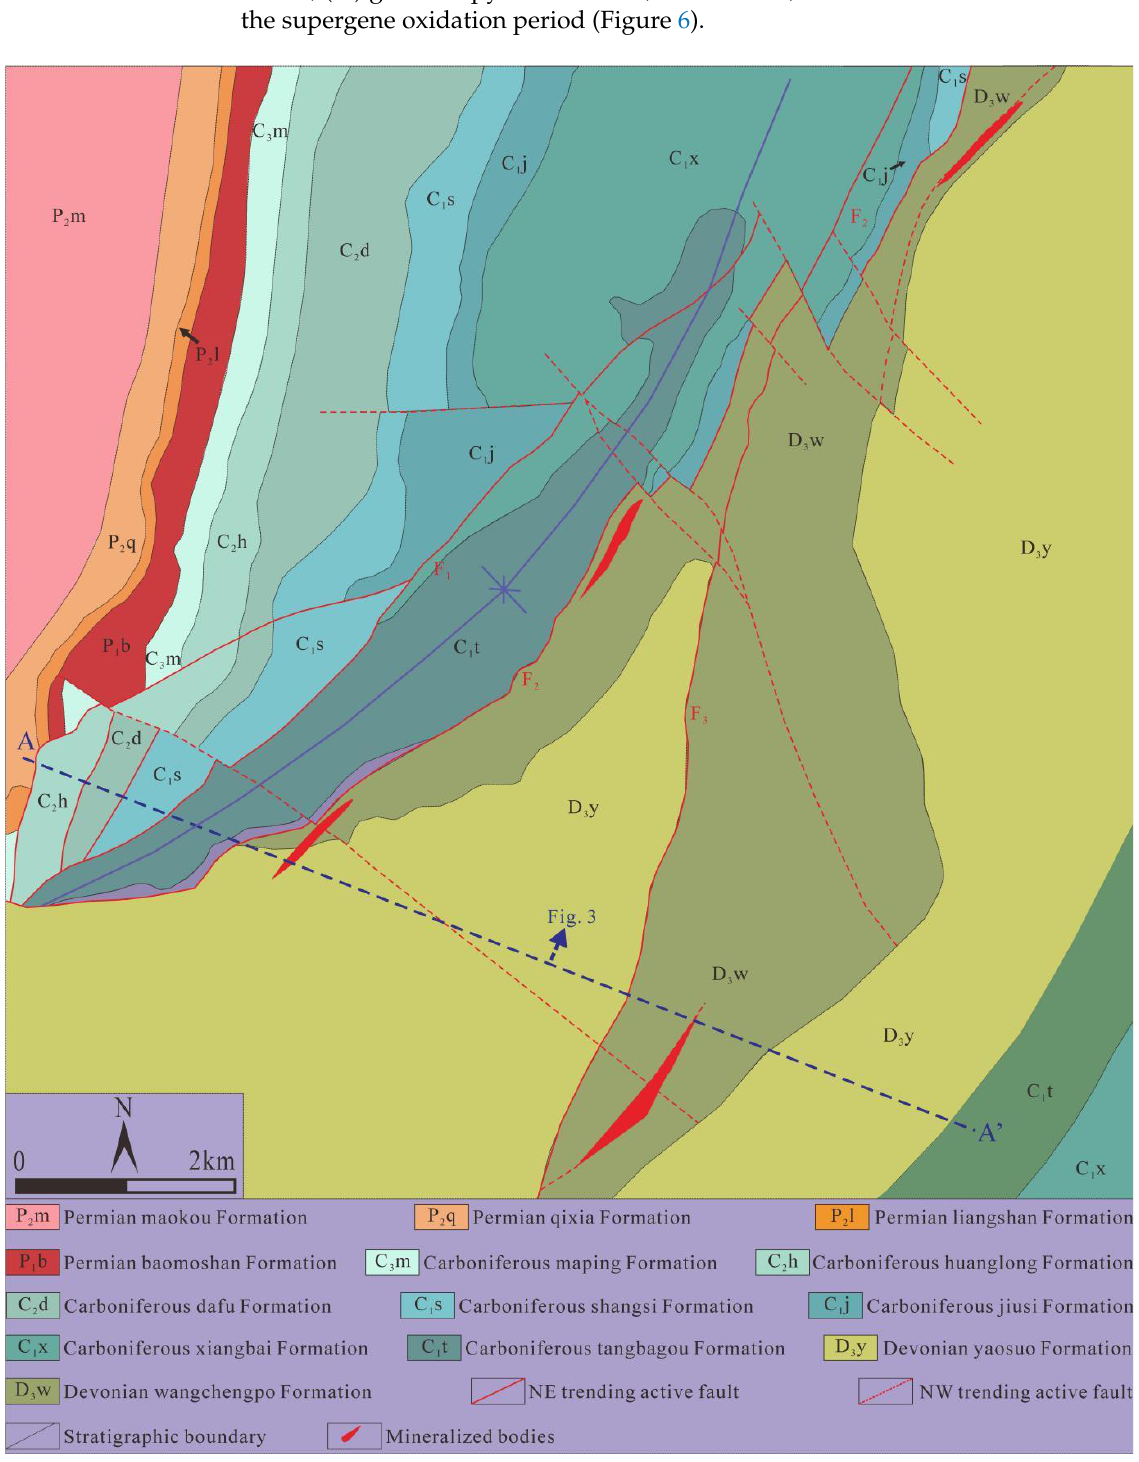
Figure 2. Geological map of Lekai Pb-Zn deposit in SYG Pb-Zn metallogenic province [42].